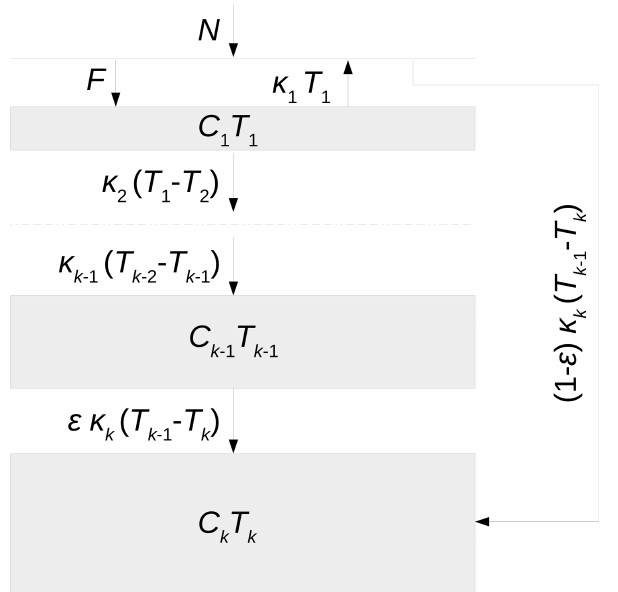
Figure 1. Vertical layout of the boxes in the k -box energy-balance model. The thickness of each box indicates its heat capacity, and the arrows represent the flow of heat between adjacent boxes. The top of the atmosphere has no heat capacity and so is represented by a horizontal line. The dashed line in the middle is an abbrevia- tion of the intervening boxes. See Cummins et al. (2020) for more